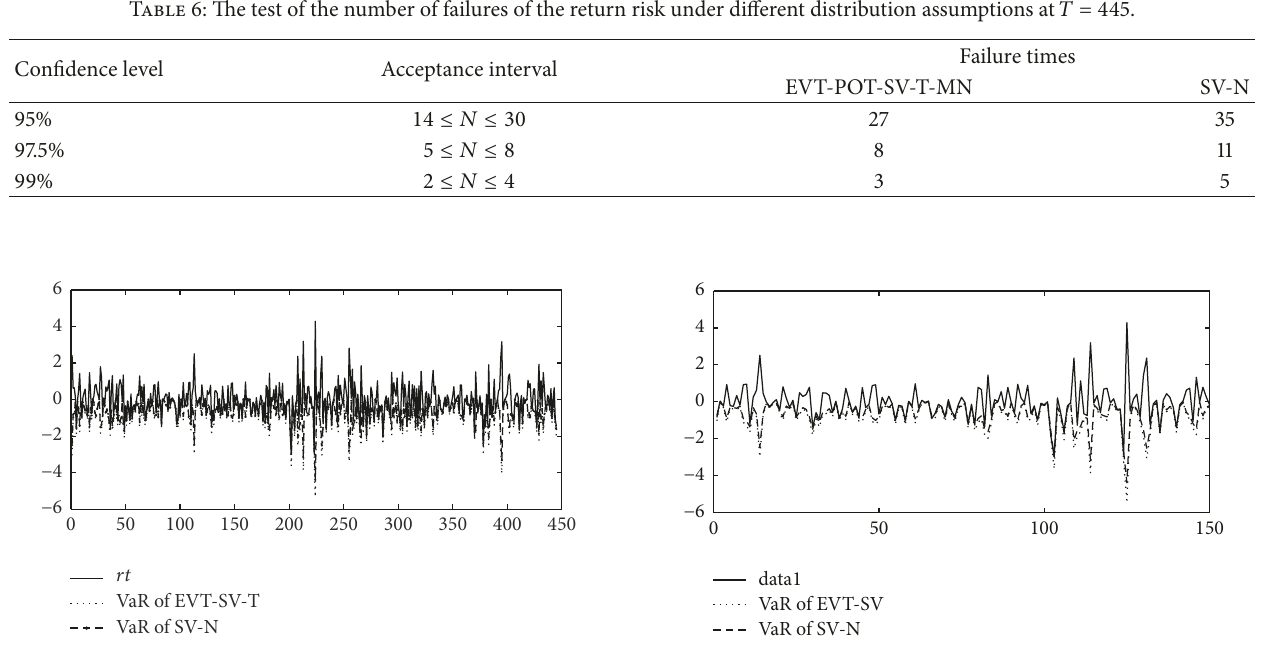
Figure 7: The VaR of the yield under the assumption of different distributions at the 95% confidence